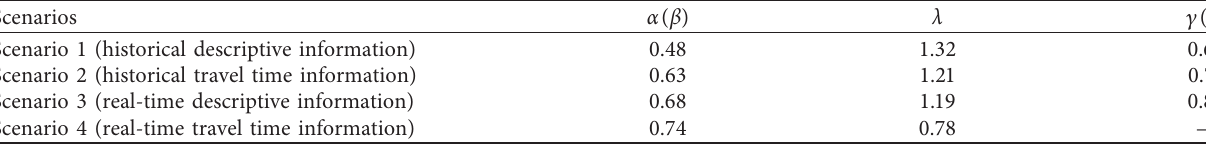
Table 4: Estimation